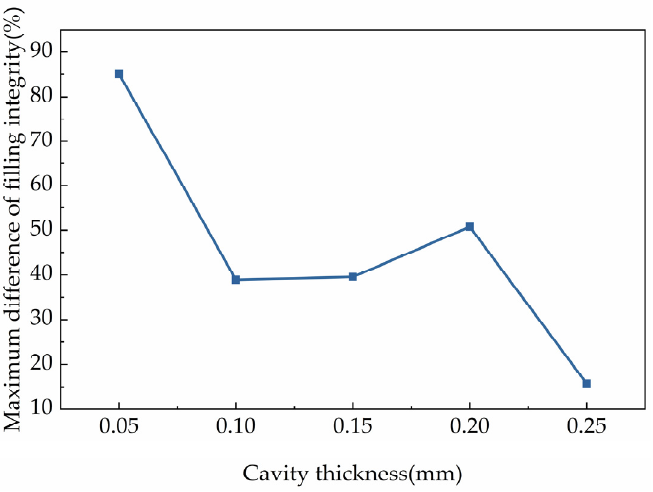
Figure 7. Maximum difference of filling integrity with different cavity thicknesses.